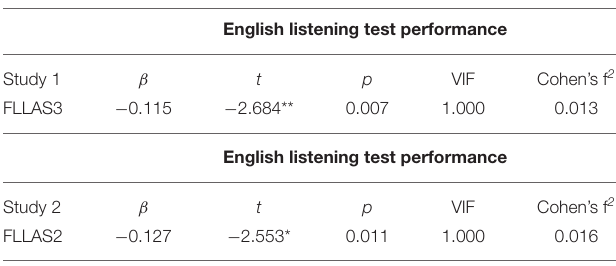
TABLE 4 | Regression coefficients and significance of predictors for english listening test performance (FLLAS scales as independent variables).